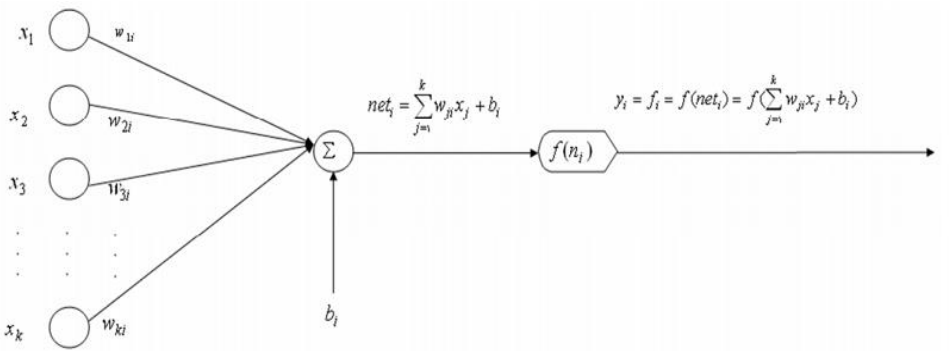
Figure 1. single-layer perceptron with multiple